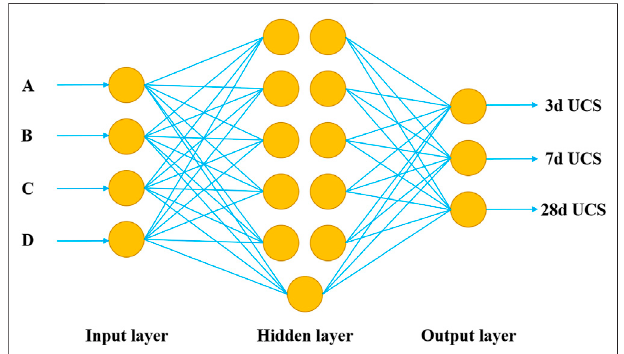
FIGURE 5 | 3-layer BP neural network